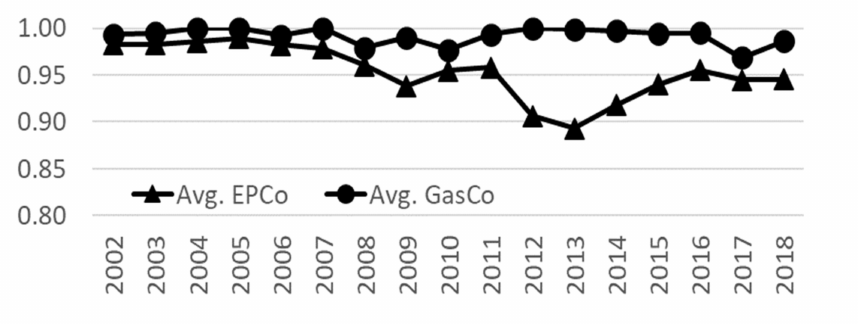
Figure 3. Operational Efficiencies (CSOE) of Utility Companies: Pooled Data. Note: See the bottom of Table 2.